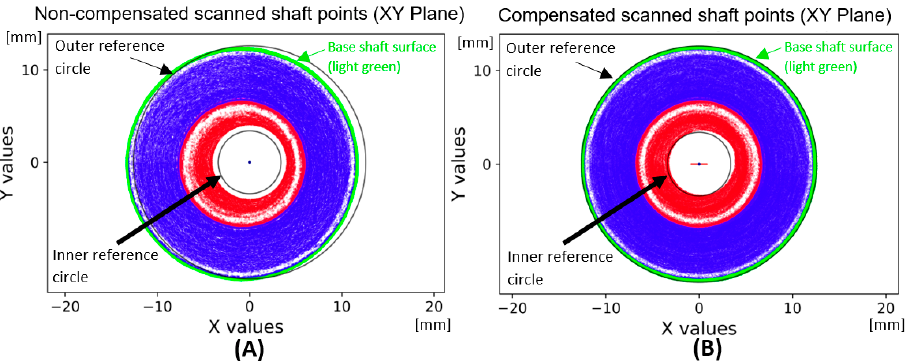
Figure 12. Comparison of rotated flatted surfaces scanned shaft to the real shape of shaft: ( A ) without compensation of eccentricity; ( B ) with compensation of eccentricity.